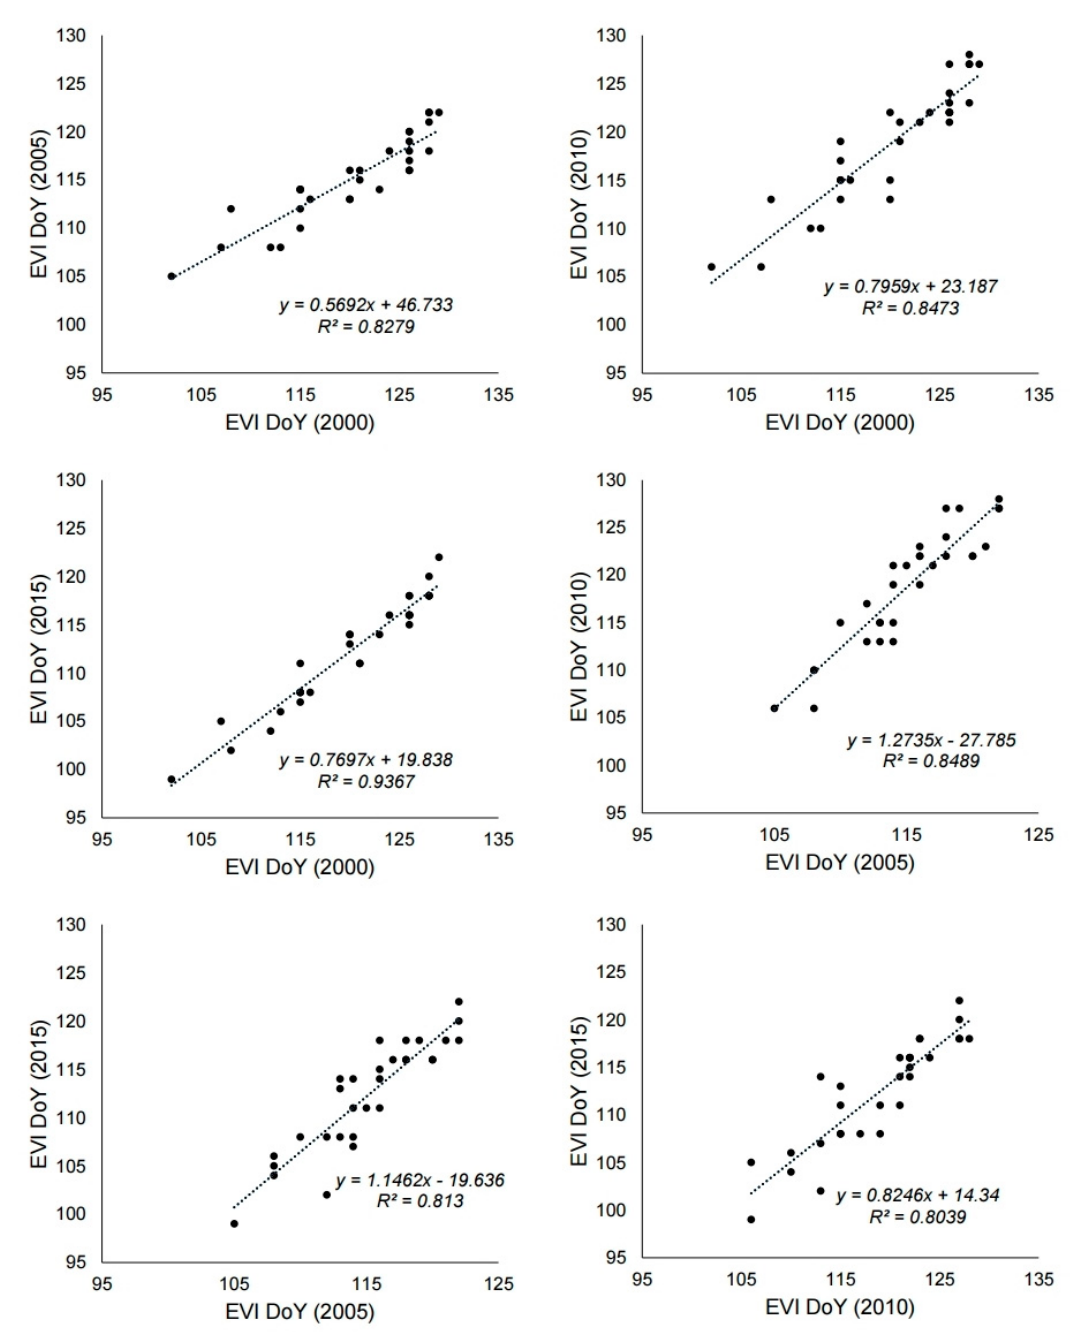
Figure 6. The relationship between green-up DoY deducted based on EVI for 30 sampling sites of Mongolian oak forests in 2000, 2005, 2010, and 2015 in South Korea. Green-up DoY in each year showed significant correlation with each other.